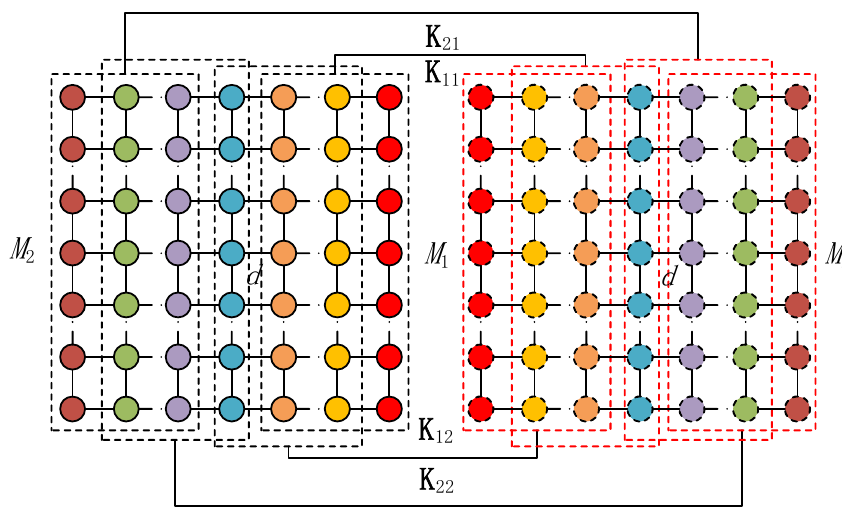
Figure 2. Block selection matrices for estimating ( θ k 1 , θ k 2 ) .